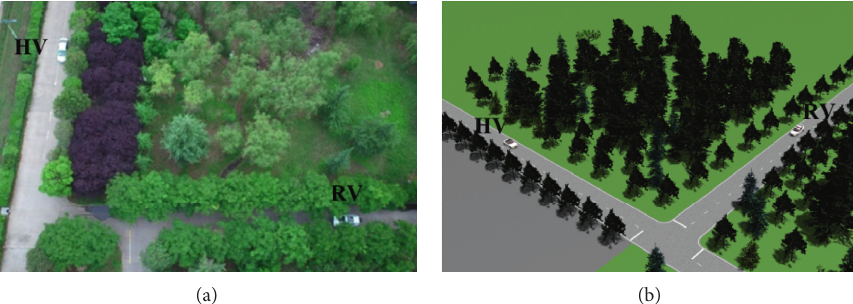
Figure 8: Tree-shaded intersection scenario for the communication performance test. (a) Actual test scenario. (b) Virtual test scenario.